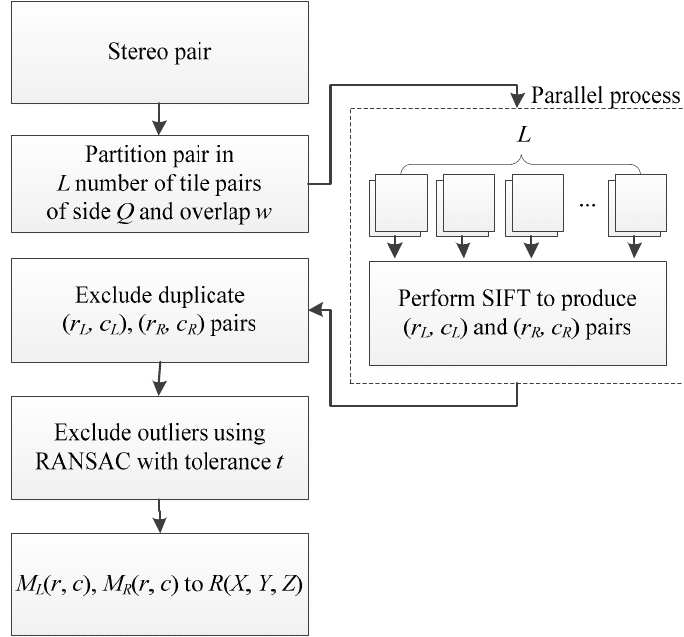
Figure 1. Satellite stereo-pair processing for the extraction of an elevation point cloud.